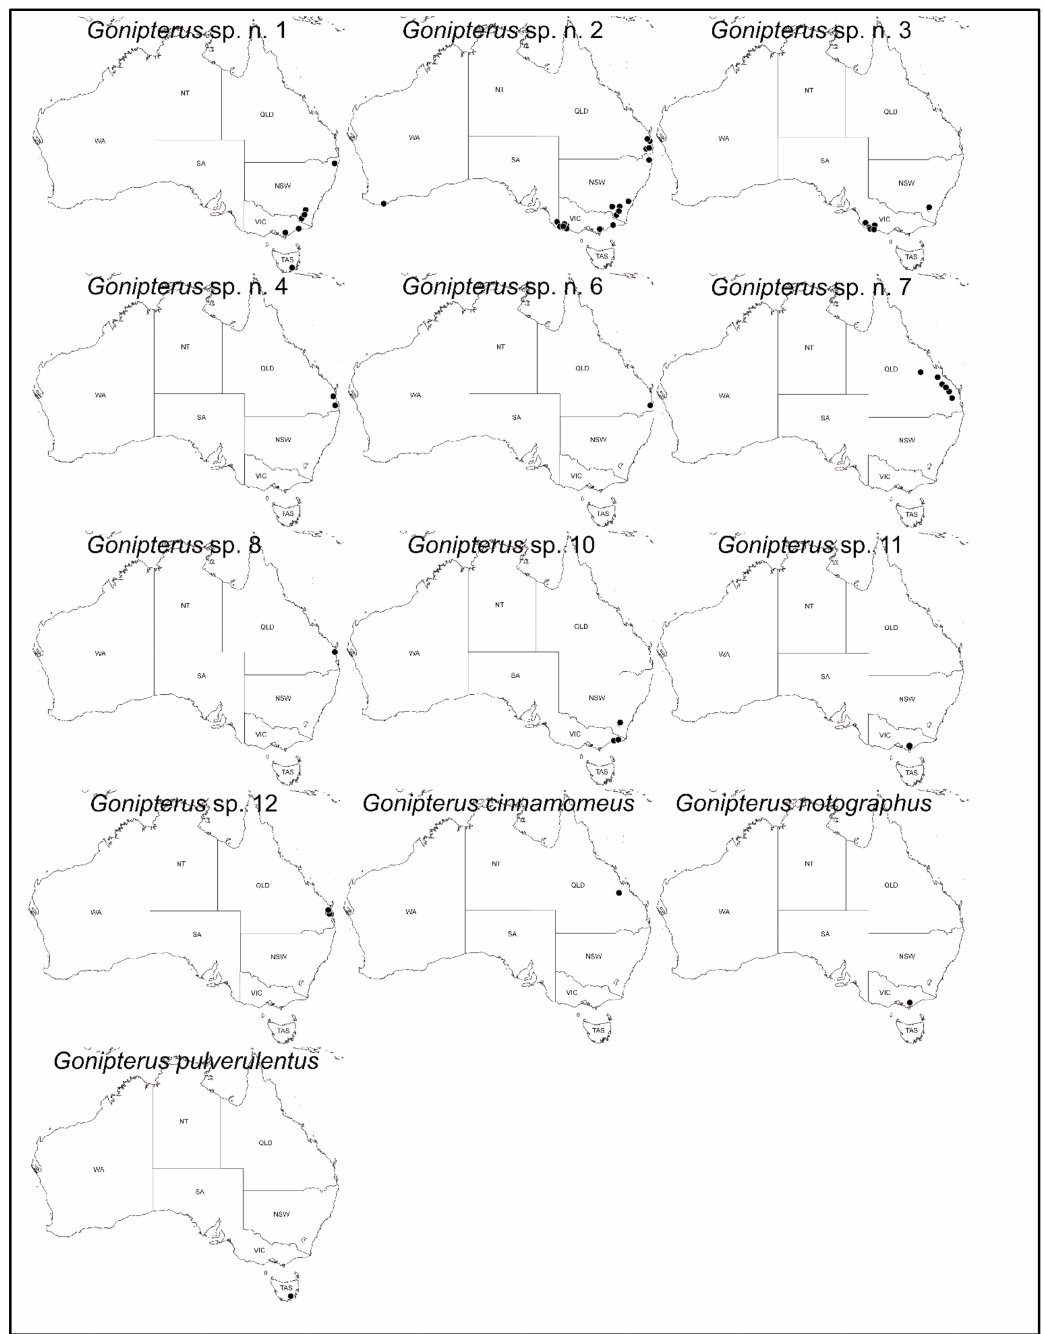
Figure 4. Geographical distribution of the previously recognized Gonipterus sp. n. 1–4, the undescribed 6 and 7, unknown Gonipterus sp. 8, 10, 11, Gonipterus sp. 12 (variety of G. inconspicuus), G. cinnamomeus, G. notographus , and G. pulverulentus in